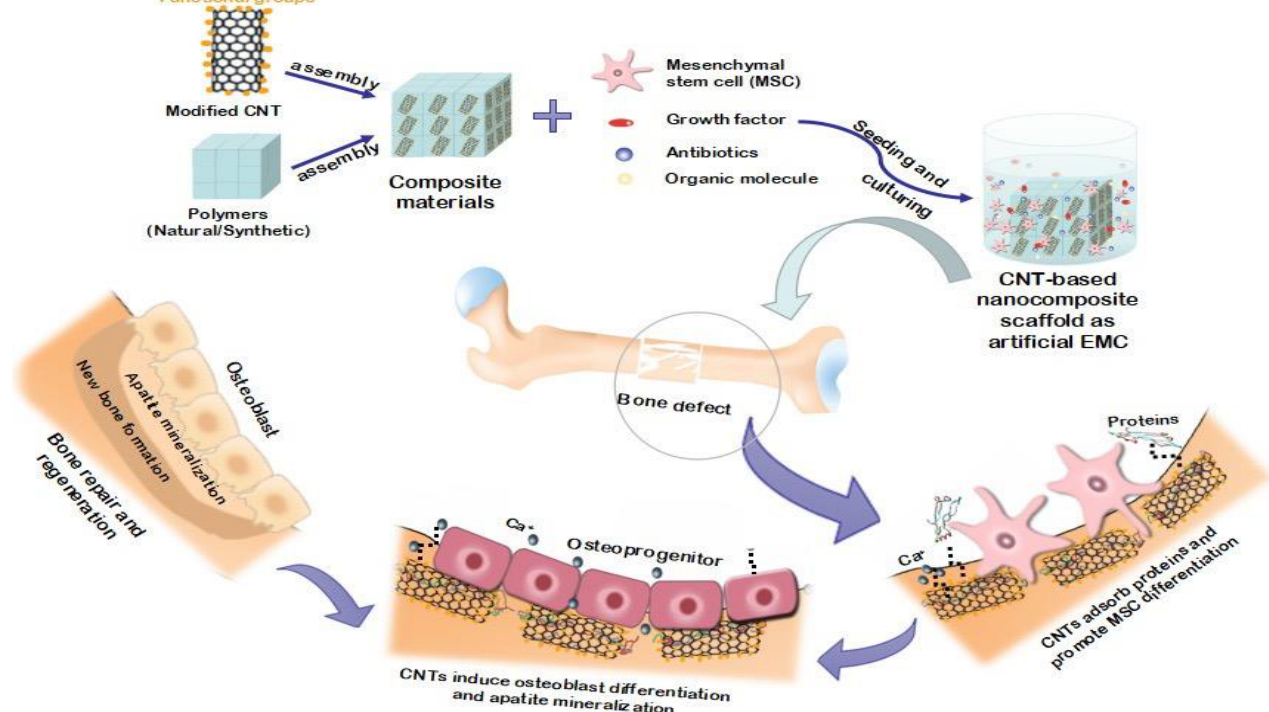
Figure 8. Diagram showing the role of carbon nanotubes (CNTs) as composite scaffolds in tissue engineering and regeneration [91].